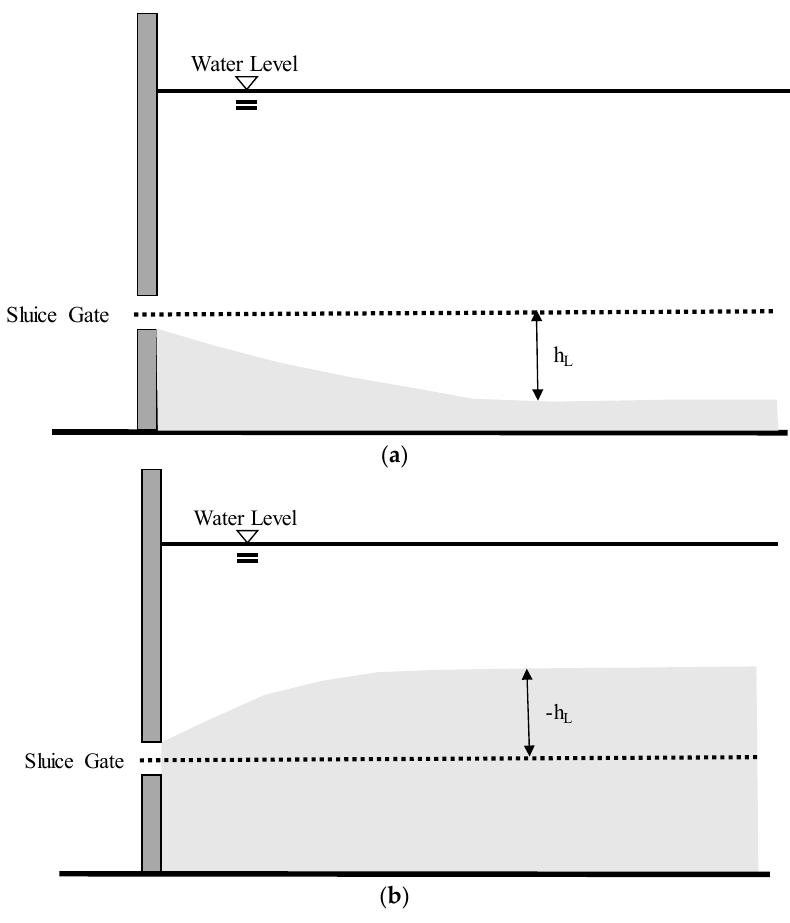
Figure 6. Definition sketch showing interface configuration at the limiting condition for: ( a ) aspiration of clear water when venting a turbidity current; ( b ) aspiration of turbid water from muddy lake through a bottom outlet.